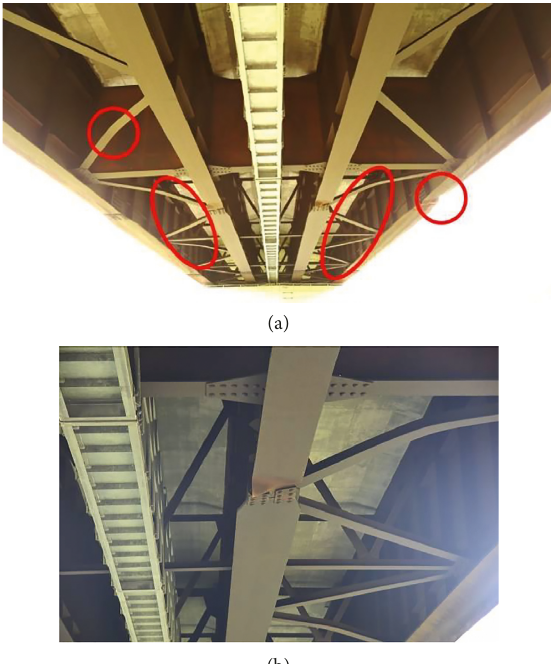
Figure 20: Deformation of the main girders and buckling of the lower lateral members.